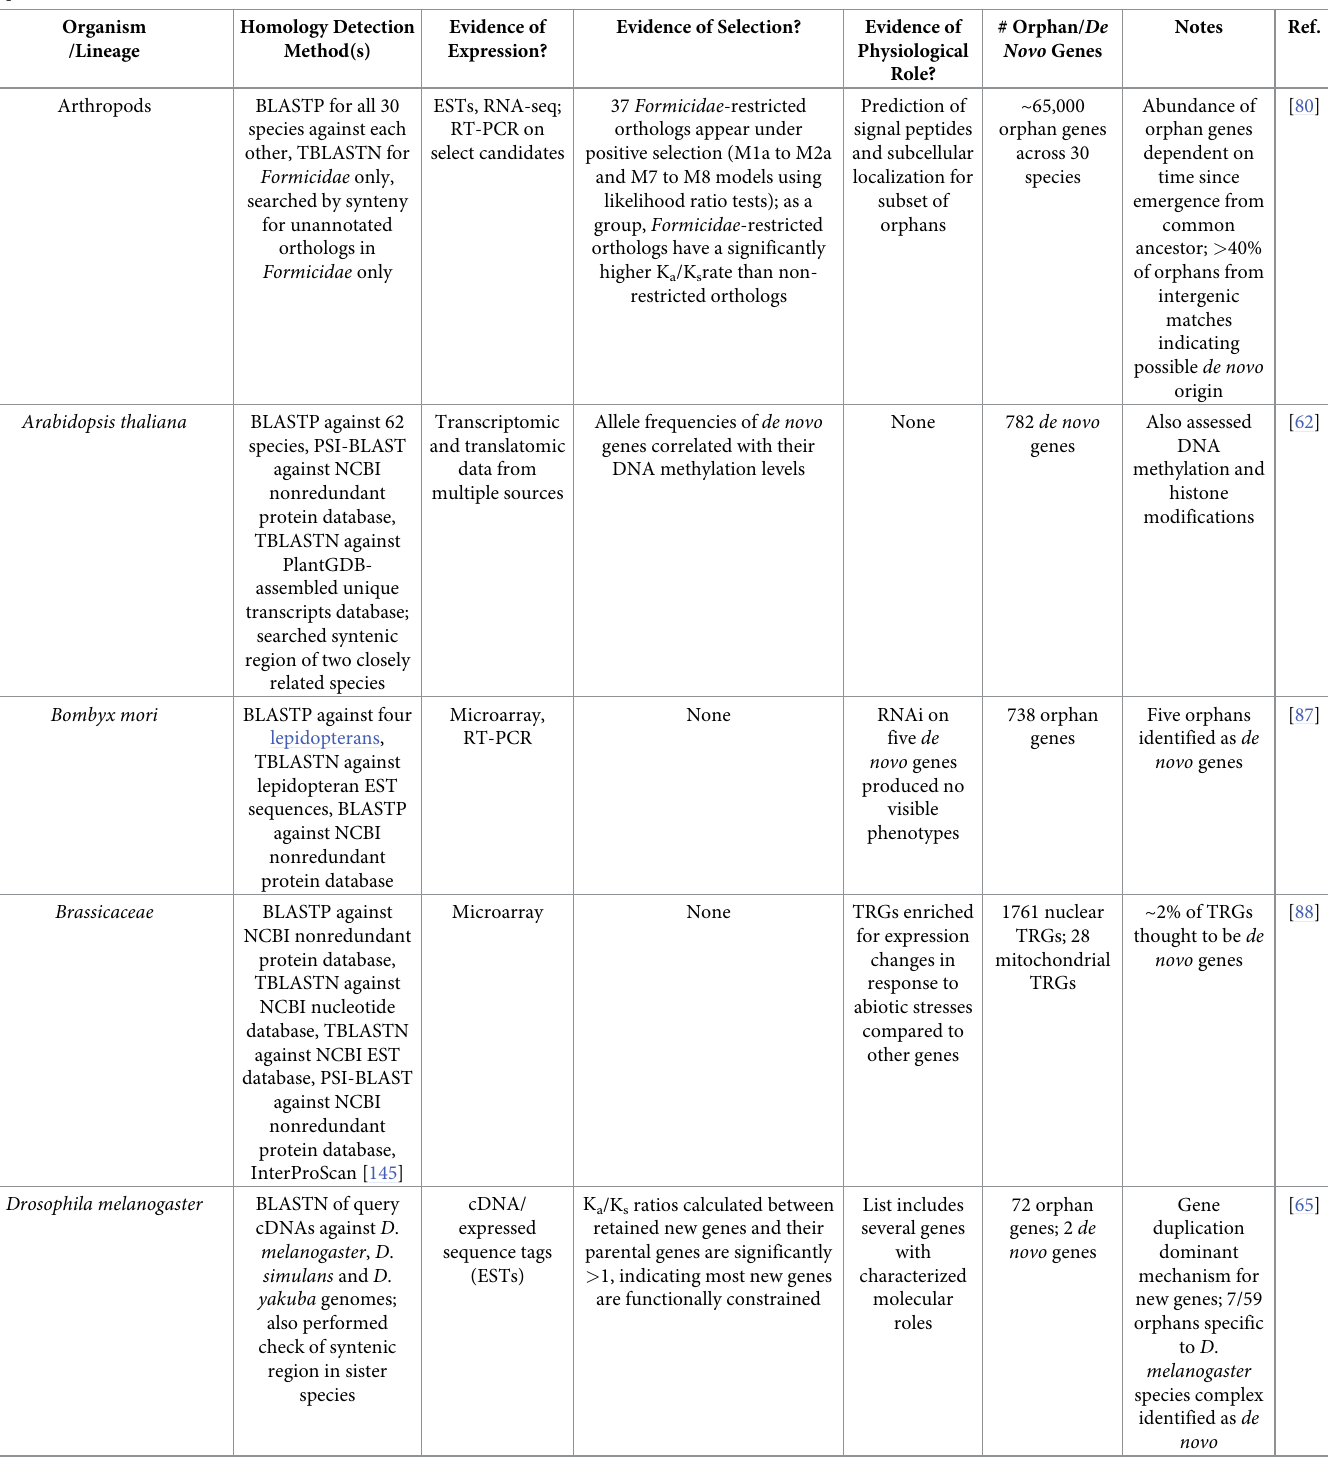
Table 1. Genome-scale studies of orphan and de novo genes in various lineages. For purposes of this table, genes are defined as orphan genes (when species-specific) or TRGs (when limited to a closely related group of species) when the mechanism of origination has not been investigated, and as de novo genes when de novo origination has been inferred, irrespective of method of inference. The designation of de novo genes as “candidates” or “proto-genes” reflects the language used by the authors of the respective